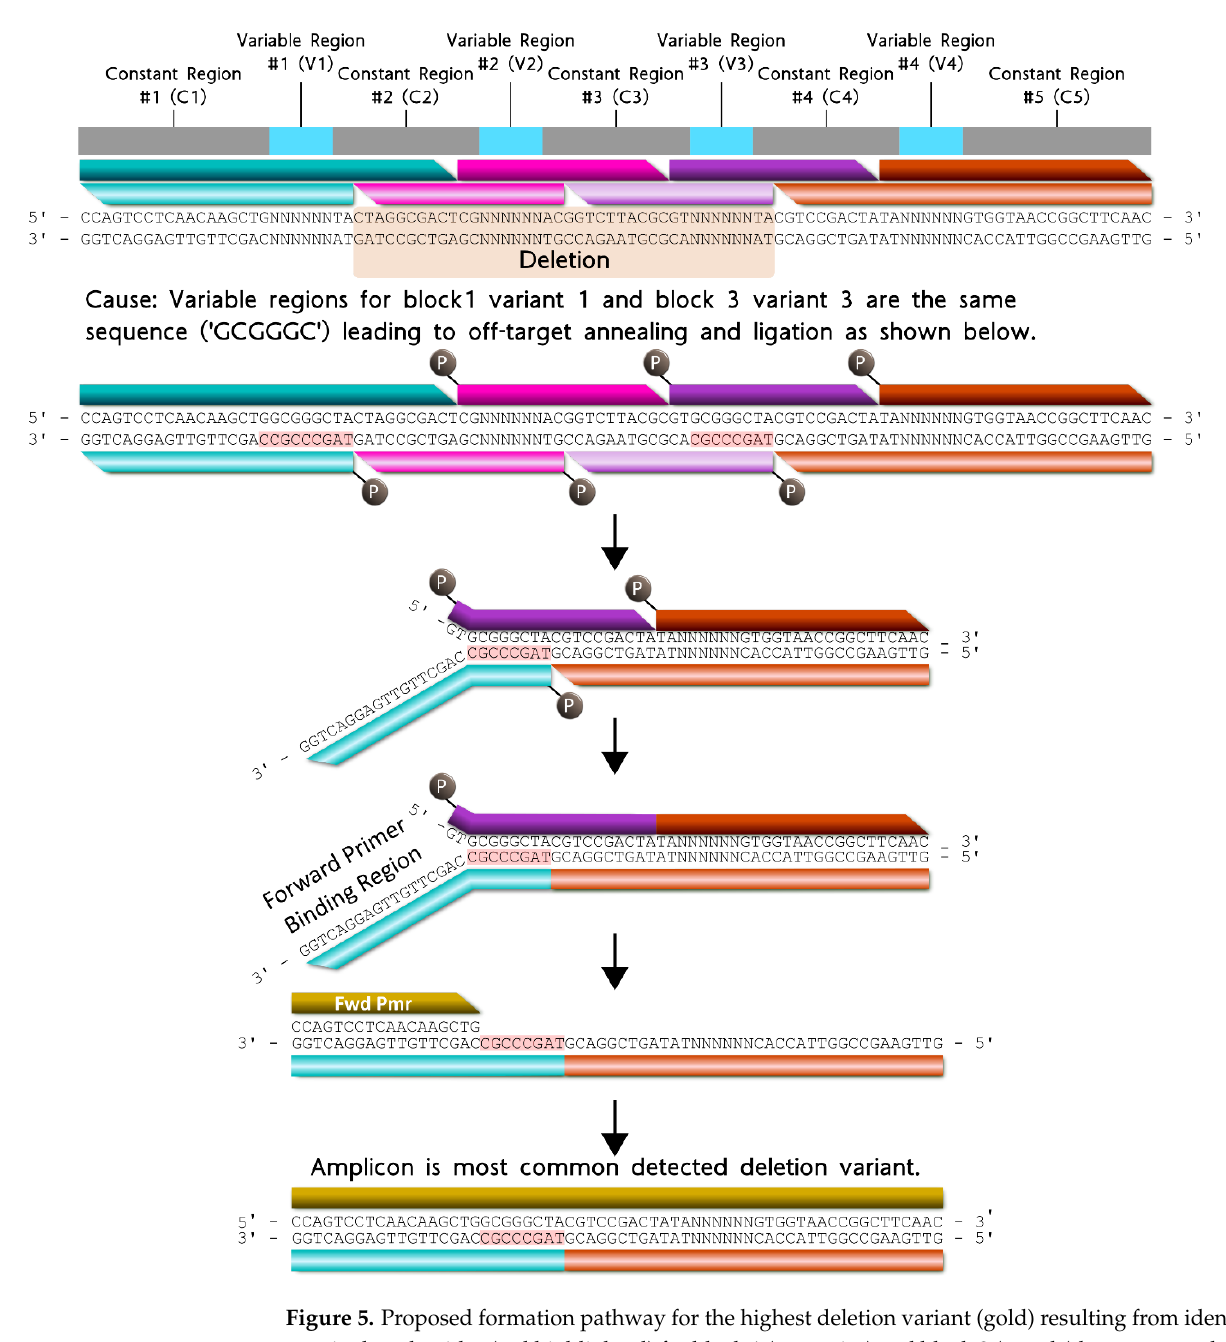
Figure 4. Gen_1 deletion variant analysis. Left, a heatmap displaying the top 10 deletion variants. Each block corresponds to a certain section within each barcode, top, with constant regions referring to overhang sequence domains between blocks and variable regions corresponding to the unique sequences internal to each block in the modular design. The number within each block represents the number of deleted nucleotides for that section. Right, a histogram displaying the detection fre- quency for the top 10 variants out of the 1 M read subset.